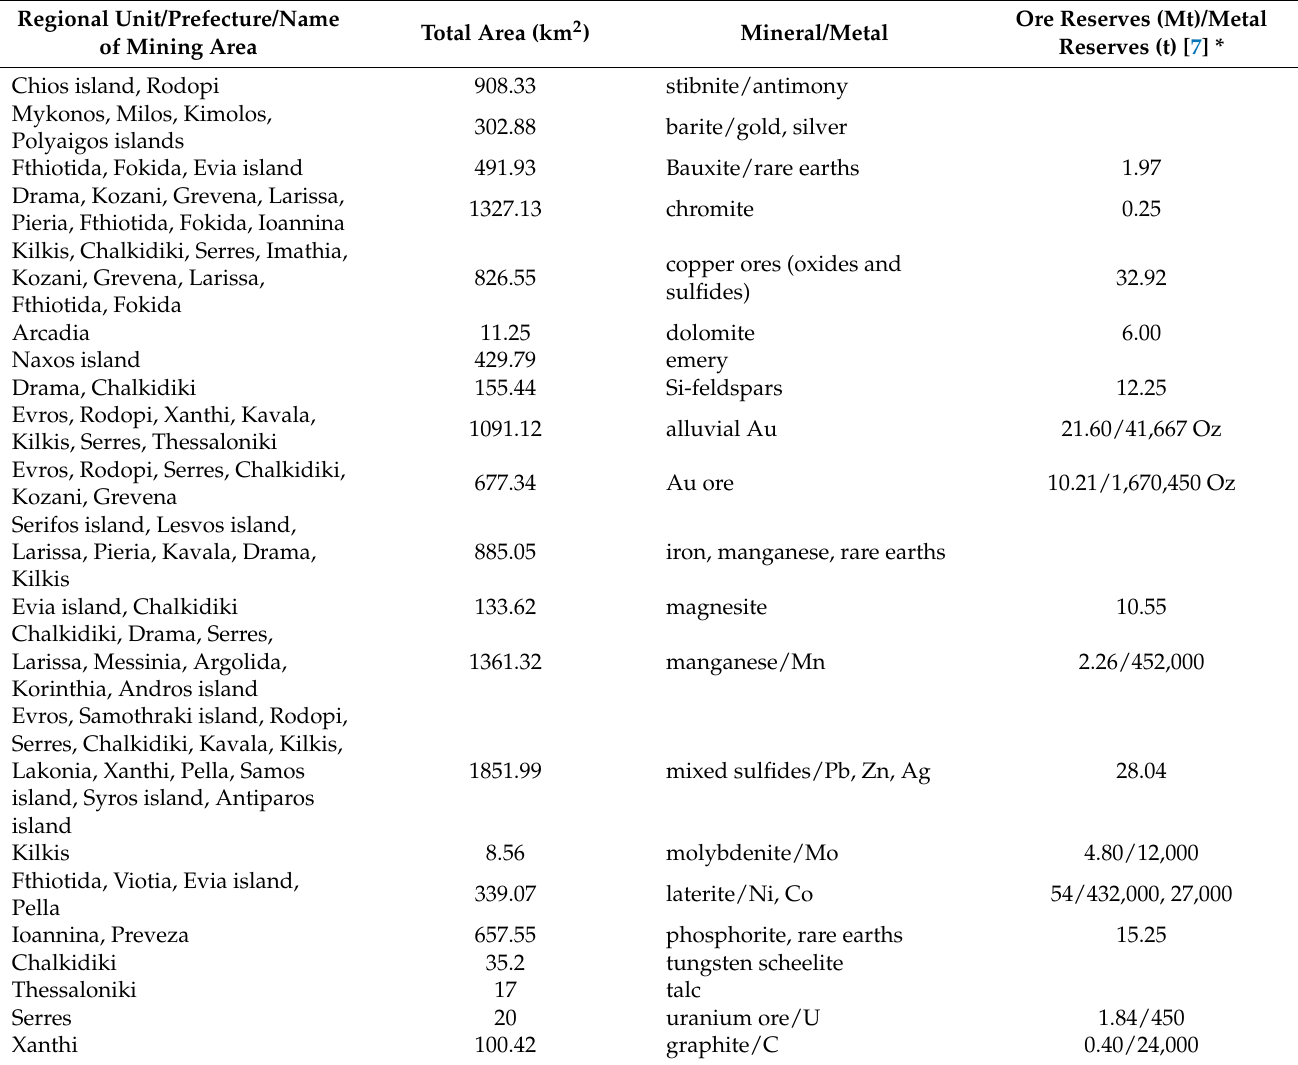
Table 2. State Mining Areas of Greece, their Prefectures, Surface Areas, Minerals and